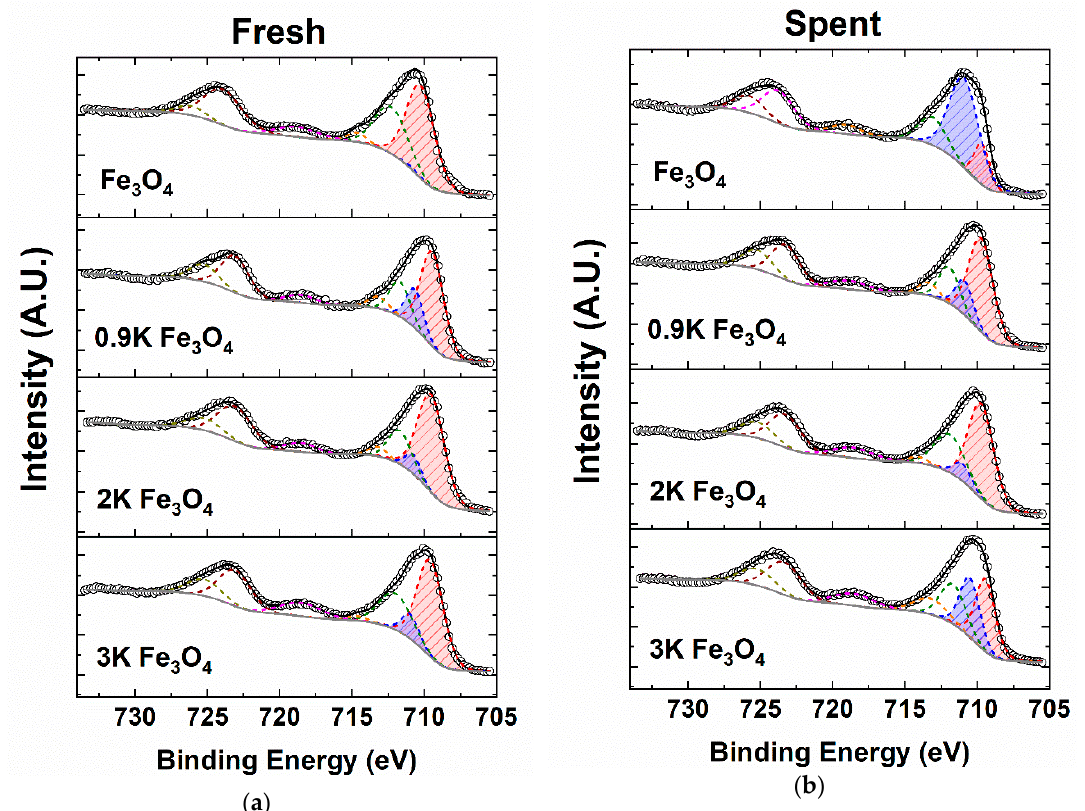
Figure 14. Fe 2p XPS spectra of: ( a ) fresh and ( b ) spent Fe 3 O 4 catalysts with varying K loadings. Colored dashed lines are the peaks utilized identified during fitting, the solid gray line is the background, and the solid black line is the fit. The two lowest binding energy peaks comprising the Fe 2p 3/2 peak are shaded red and blue to emphasize changes with K loading and the effect of reaction environment.